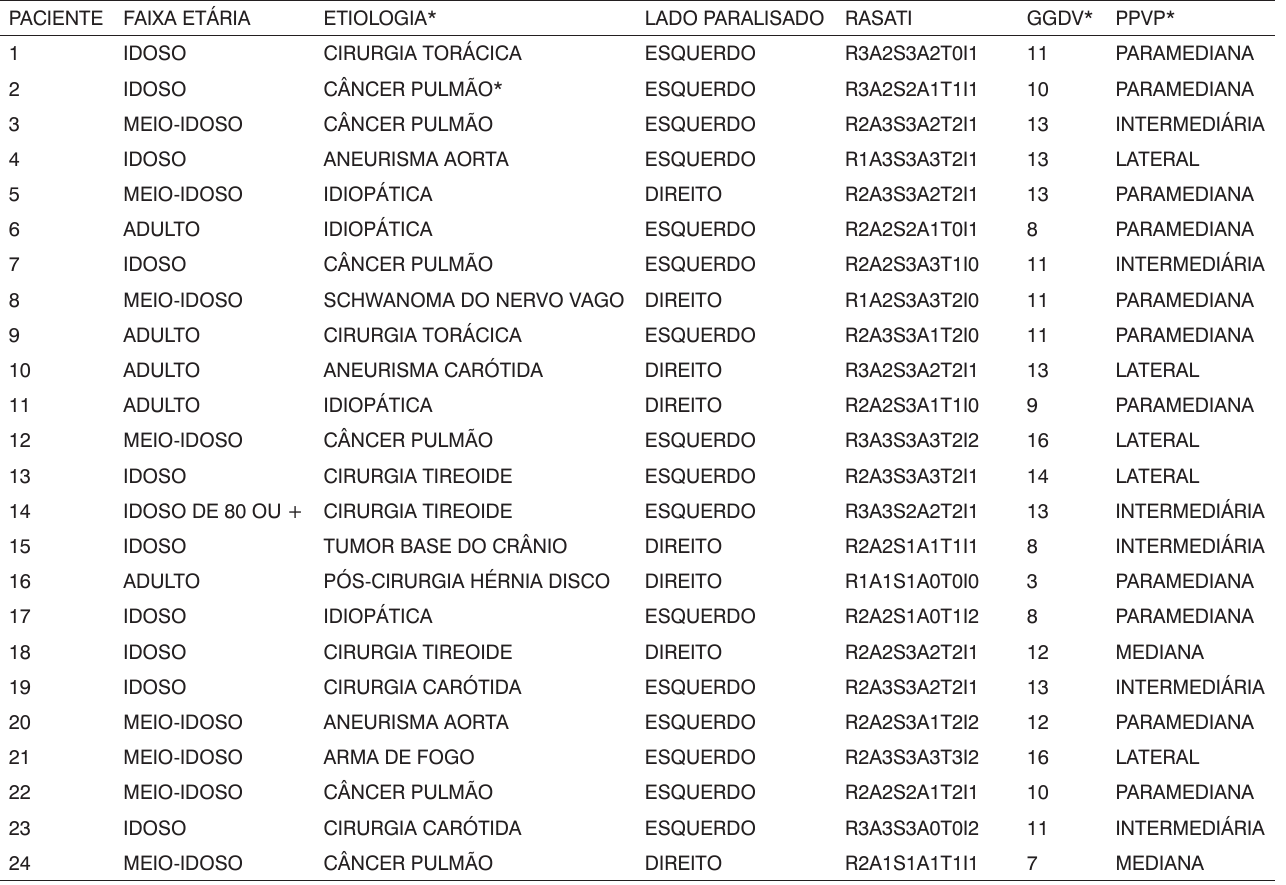
Tabela 1. Caracterização dos pacientes quanto à etiologia da PPVU, lado paralisado, avaliação perceptivo-auditiva com a escala RASATI, grau geral de desvio vocal e posição da prega vocal paralisada